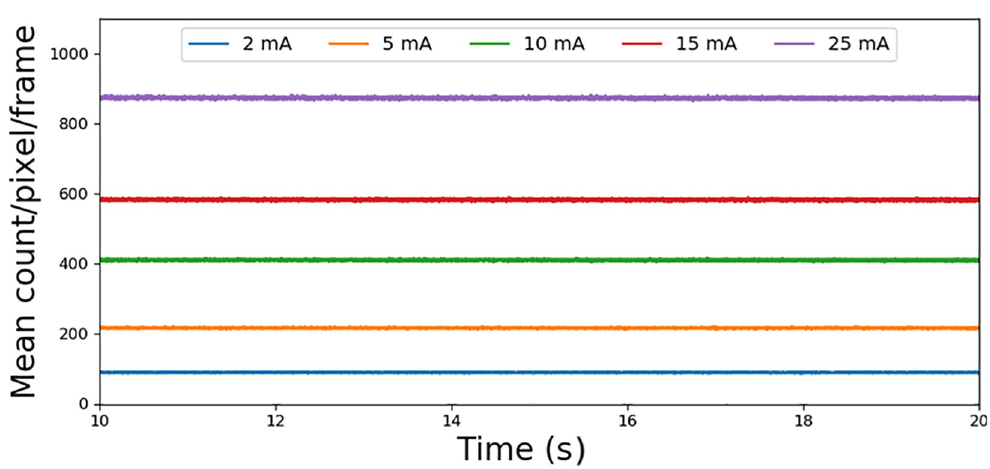
Fig 11. Stability of mean pixel (25 pixels) counts per frame in 20 s for varying tube currents at 120 kVp tube voltage. Mean pixel counts and SD were 90 ± 1.0 (2 mA), 217 ± 1.4 (5 mA), 411 ± 1.9 (10 mA), 583 ± 2.1 (15 mA), and 874 ± 2.5(25 mA), respectively.